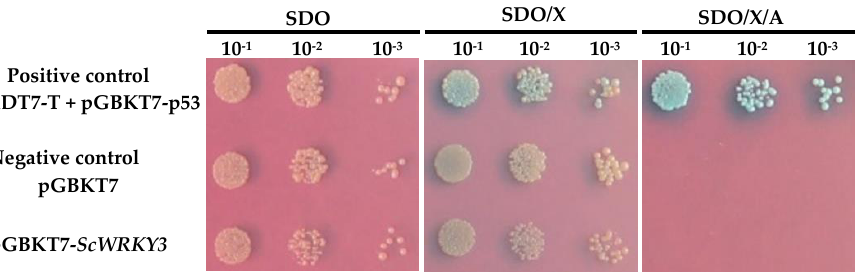
Figure 5. Testing of the ScWRKY3 transactivation activity assay. SDO (SD/-Trp), synthetic dropout medium without tryptophan; SDO/X (SD/-Trp/X- α -Gal), synthetic dropout medium without tryptophan, but plus 5-bromo-4-chloro-3-indoxyl- α -D-galactopyranoside; SDO/X/A (SD/-Trp/X- α - Gal/AbA), synthetic dropout medium without tryptophan, but plus 5-bromo-4-chloro-3-indoxyl- α - D - galactopyranoside and aureobasidin A.